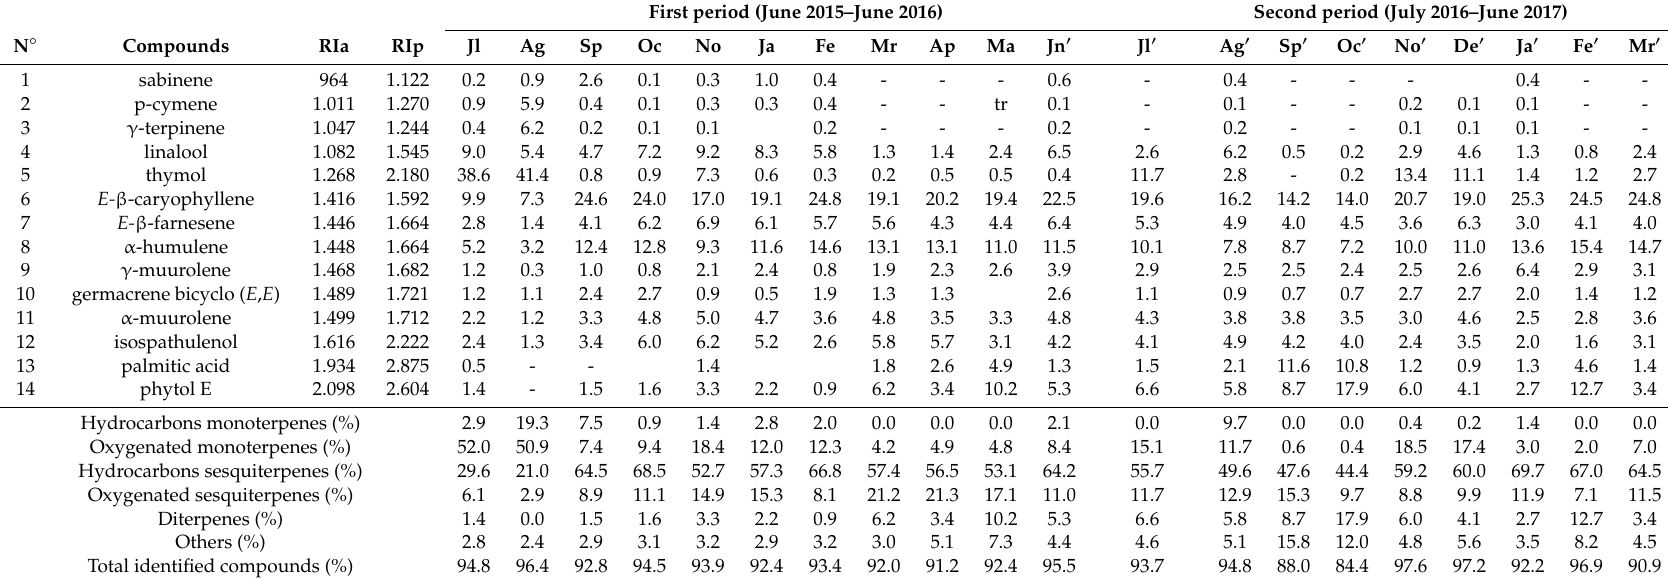
Table 4. Major compounds and total identified compounds in stems’ essential oils of Lantana camara from